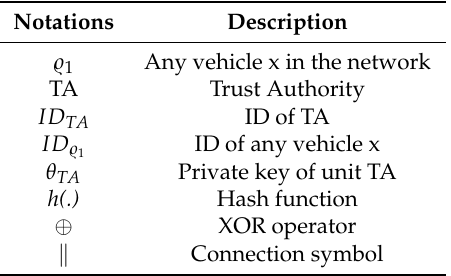
Table 2. The notation and specific